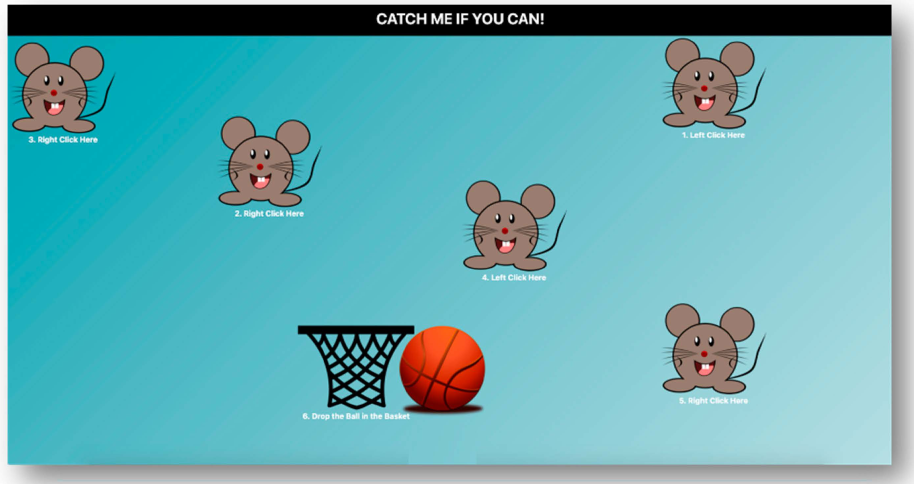
Figure 1. The web-site ‘Catch Me if You